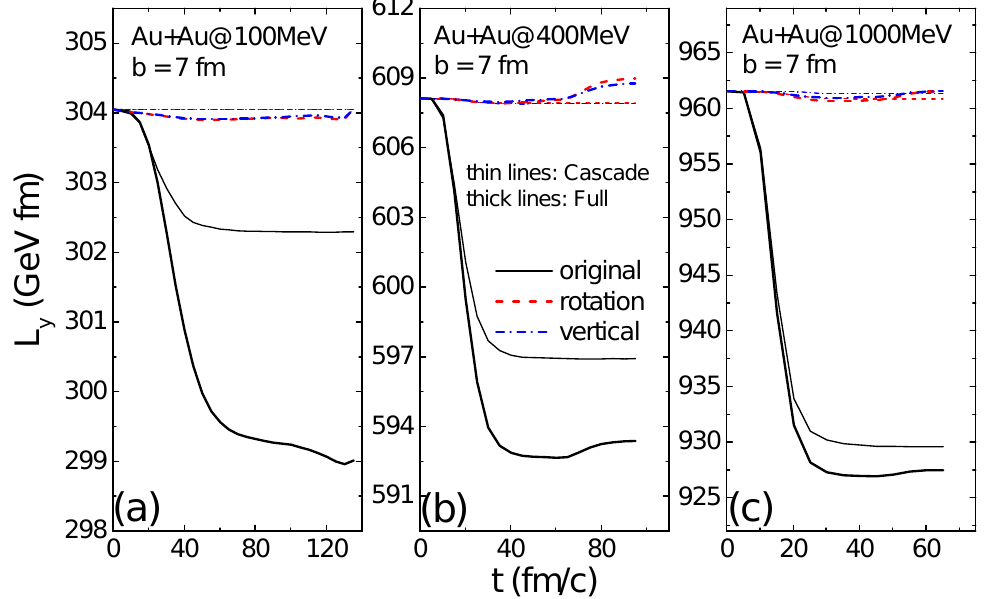
Figure 3. Time evolution of the total angular momentum perpendicular to the reaction plane from three collision prescriptions without (Cascade) and with (Full) nucleon mean-field potentials in non-central Au+Au collisions at E lab = 100 ( a ); 400 ( b ); and 1000 ( c )